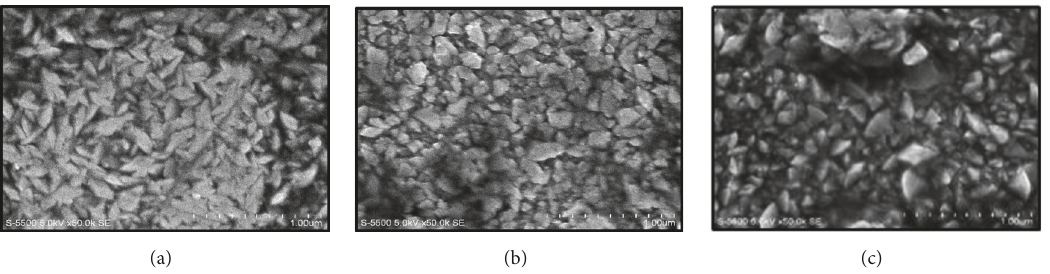
Figure 2: SEM images of PbS thin film grown for (a) 2 min, (b) 3 min, and (c) 4 min.